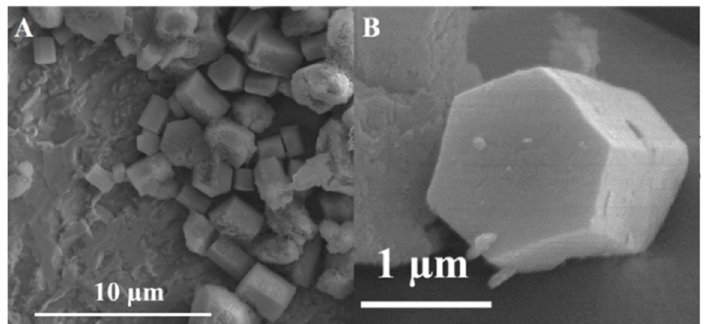
Figure 5. SEM images ( A and B ) of the prepared ZrP prisms. Reproduced from [63], with permission from the American Chemical Society, 2020.